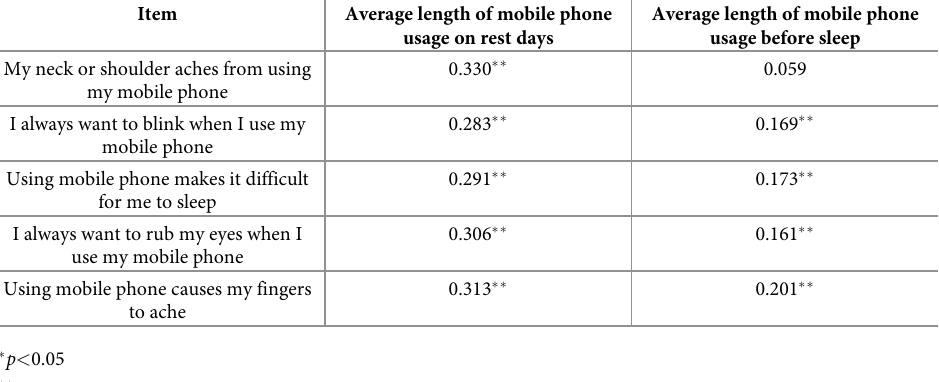
Table 8. Pearson Correlation Coefficient between mobile phone usage duration and physical state.